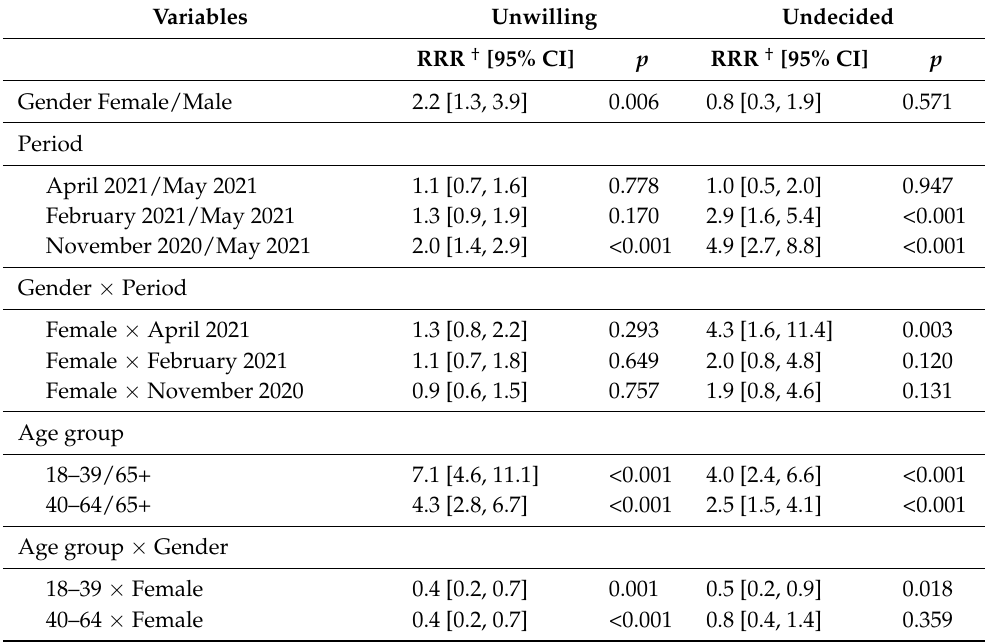
Table 3. Predictors of unwillingness and uncertainty to be vaccinated against COVID-19 based on the data collected from the four cross-sectional surveys in Greece (results from multivariable analysis, N = 4682